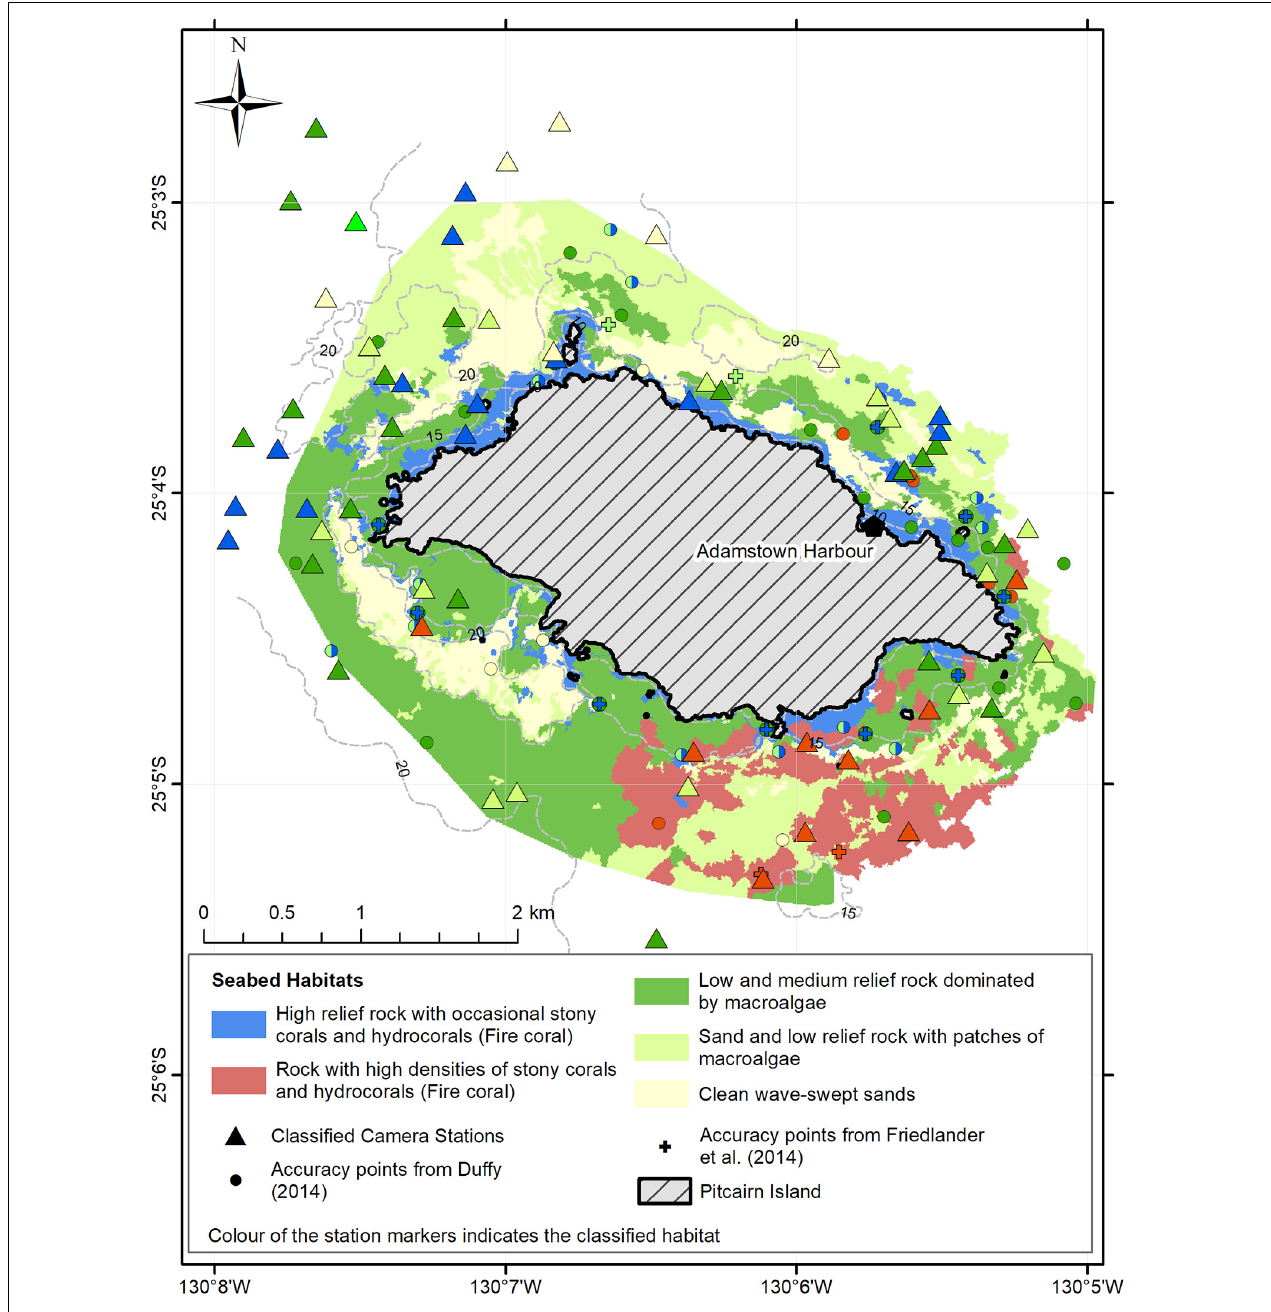
FIGURE 3 | Spatial distribution of the five habitats around Pitcairn Island with the limit being approximately the 20 m depth contour. Individual points for the classified video samples and the historical datasets used for assessing accuracy are also